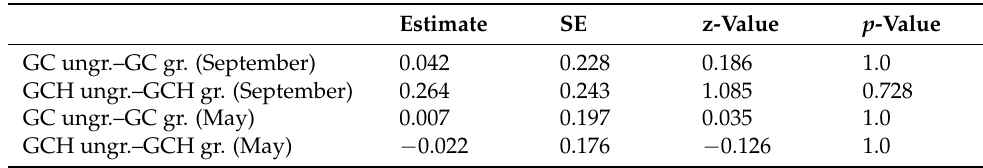
Table A24. Differences in species richness of open-habitat carabid beetles, comparing the grazed pastures and ungrazed strips of the grass–clover (GC) and the grass–clover herbs (GCH) in May/June and September.